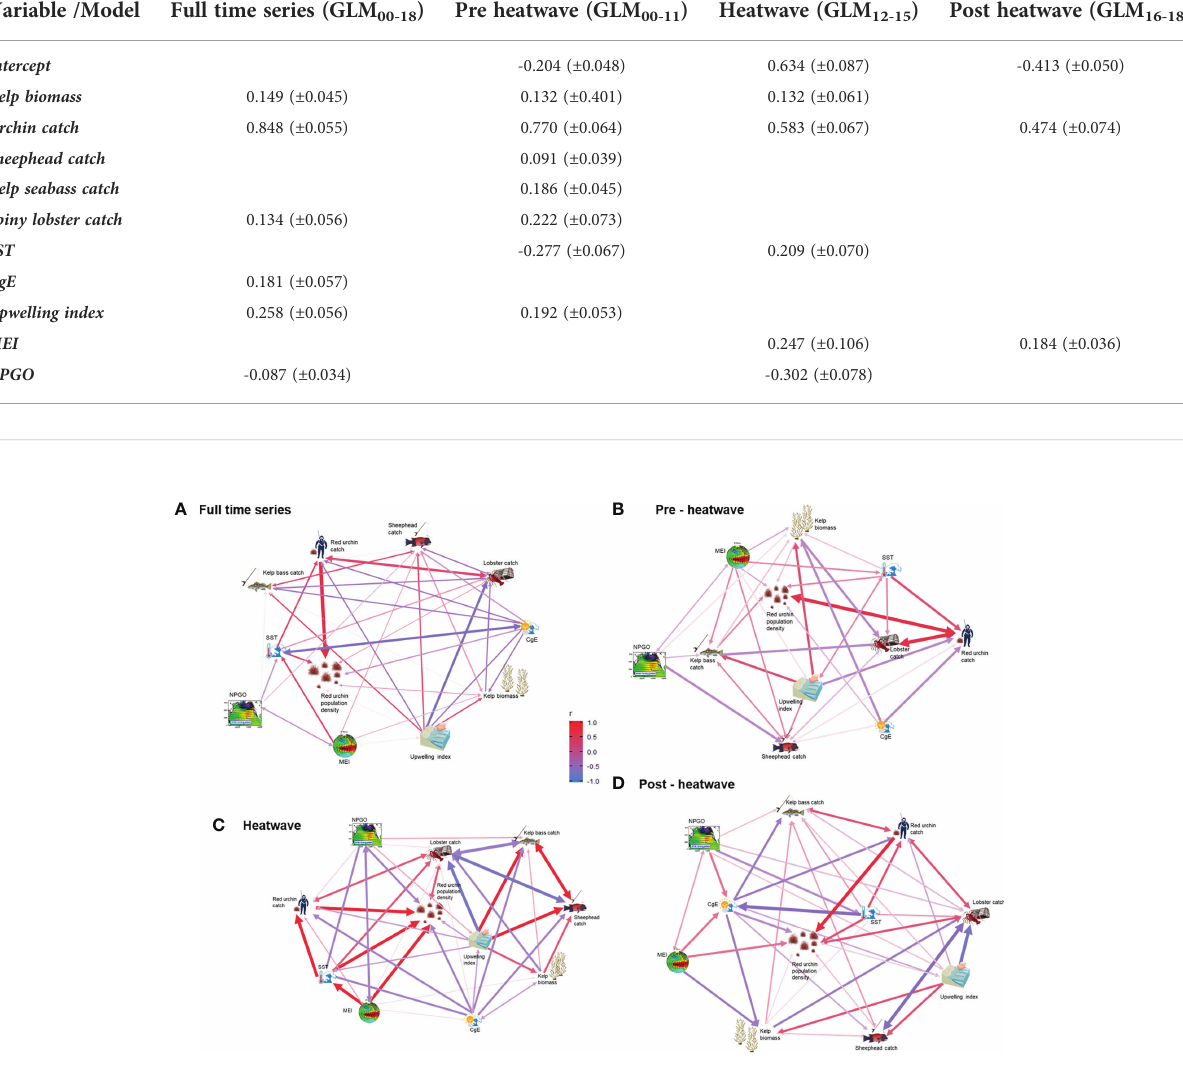
FIGURE 6 Correlogram of variables that could in fl uence the abundance of red sea urchins along the Paci fi c coast of Baja California. Correlations were analyzed under different conditions: (A) Full-time series (2000 – 2018); (B) Pre – heatwave (2000 – 2011); (C) Heatwave (2012 – 2015); (D) Post – heatwave (2016 –